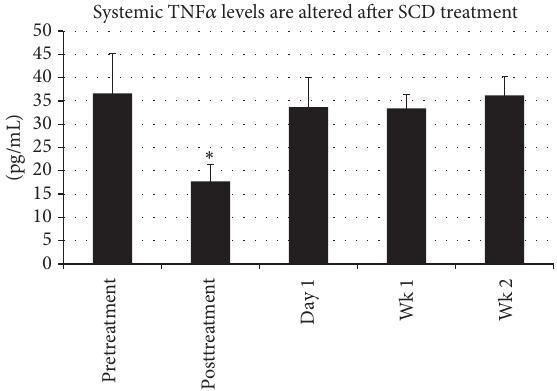
Figure 5: Analysis of circulating levels of TNF 𝛼 was completed for MET03 and MET04 before each treatment (pretreatment), immediately after each 6-hour treatment period (posttreatment), and day 1, week 1, and week 2 following the third treatment. A decrease in TNF 𝛼 was consistently observed from pretreatment to posttreatment, with high significance achieved ( 𝑝 < 0.003 ∗ ) when averaging all pretreatment (A, B, and C) levels ( 𝑛 = 9 ) and comparing to all posttreatment (A, B, and C) averaged levels ( 𝑛 = 9 ), providing strong evidence that SCD therapy is able to reduce the chronic systemic inflammation associated with MetS as presented in this